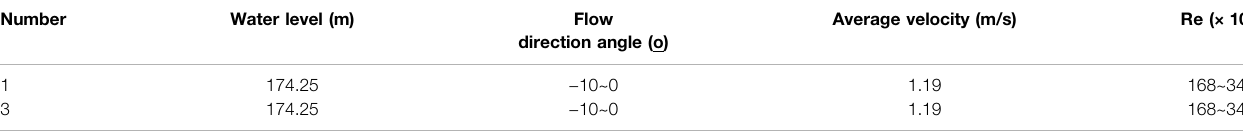
TABLE 1 | The wharf fi eld hydrological conditions.